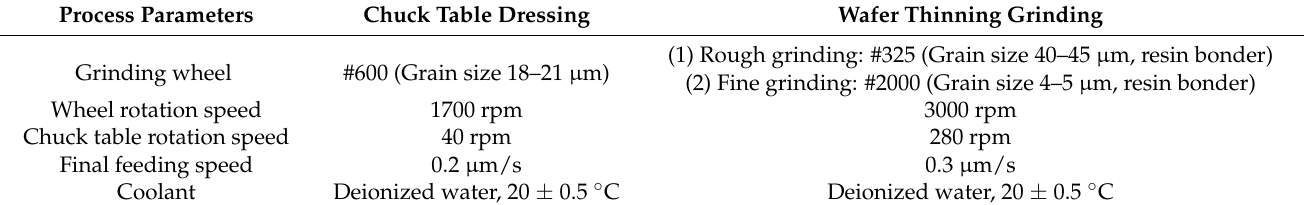
Table 1. Process parameters in the experiments of chuck table dressing and wafer grinding.